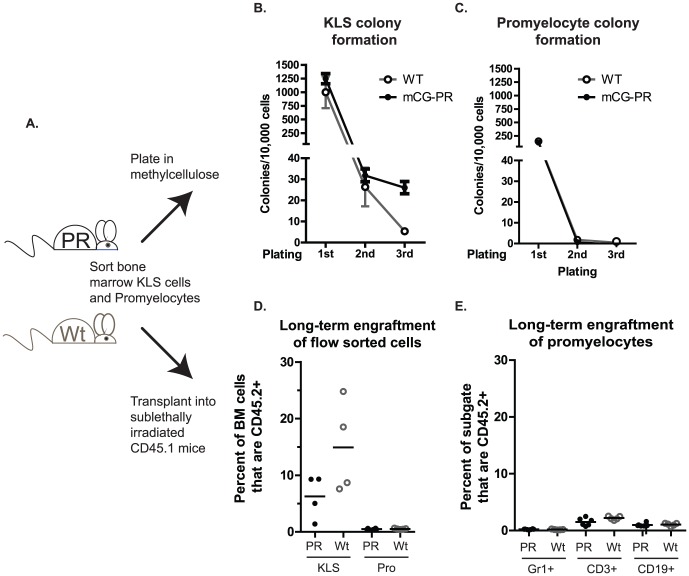
Effects of Ctsg-PML-RARA on flow-sorted promyelocytes.A. Experimental schema. Bone marrow cells from Ctsg-PML-RARA and littermate WT controls were harvested and KLS and promyelocytes were purified by flow sorting. Aliquots from individual donor mice were plated in methylcellulose containing myeloid cytokines (SCF, IL-3, IL-6, Epo). KLS cells were combined from all donors by genotype and 3,000 cells/recipient were transferred to sub-lethally irradiated Ly5.1 mice (4 recipients per genotype). Purified promyelocytes were separated into two pools, and 50,000 cells/recipient were transferred into sub-lethally irradiated Ly5.1 mice. B. Total CFUs per 10,000 KLS cells plated by week. Every 7 days, total colonies were counted. Total cells were then collected in warm (37°) media and serially replated. C. Total CFUs per 10,000 promyelocytes plated by week. D. Percentage of donor CD45.2+ cells in total bone marrow cells of individual recipient mice 12 weeks after engraftment, with indicated flow sorted cells. All mice that received promyelocytes had <1% CD45.2+ cells. E. Percentage of CD45.2+ cells within the Gr1+, CD3+, and CD19+ bone marrow cells of mice engrafted with promyelocytes.